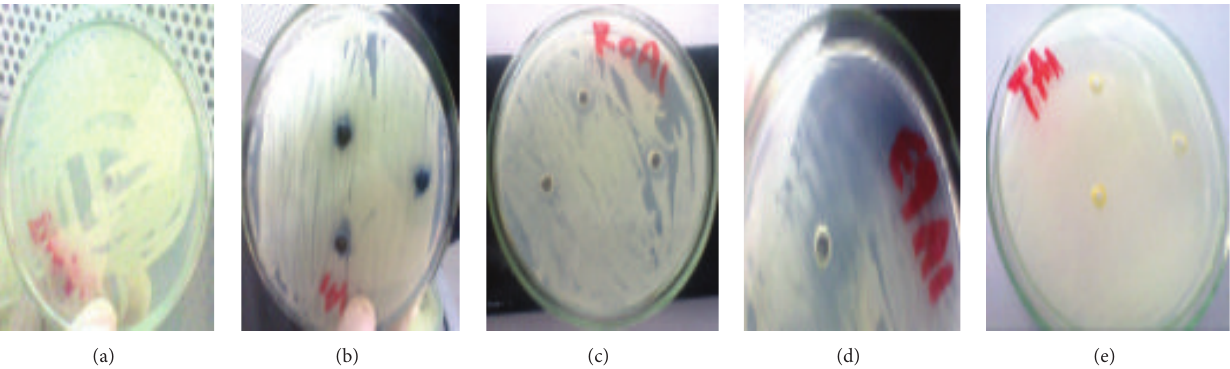
Figure4: Growthinhibition zoneon Aspergillus spp1((a)=DMSO, (b)= Matricaria chamomilla , (c)= Rosmarinus officinalis , (d)= Eucalyptus globulus , and (e) = Thymus schimperi